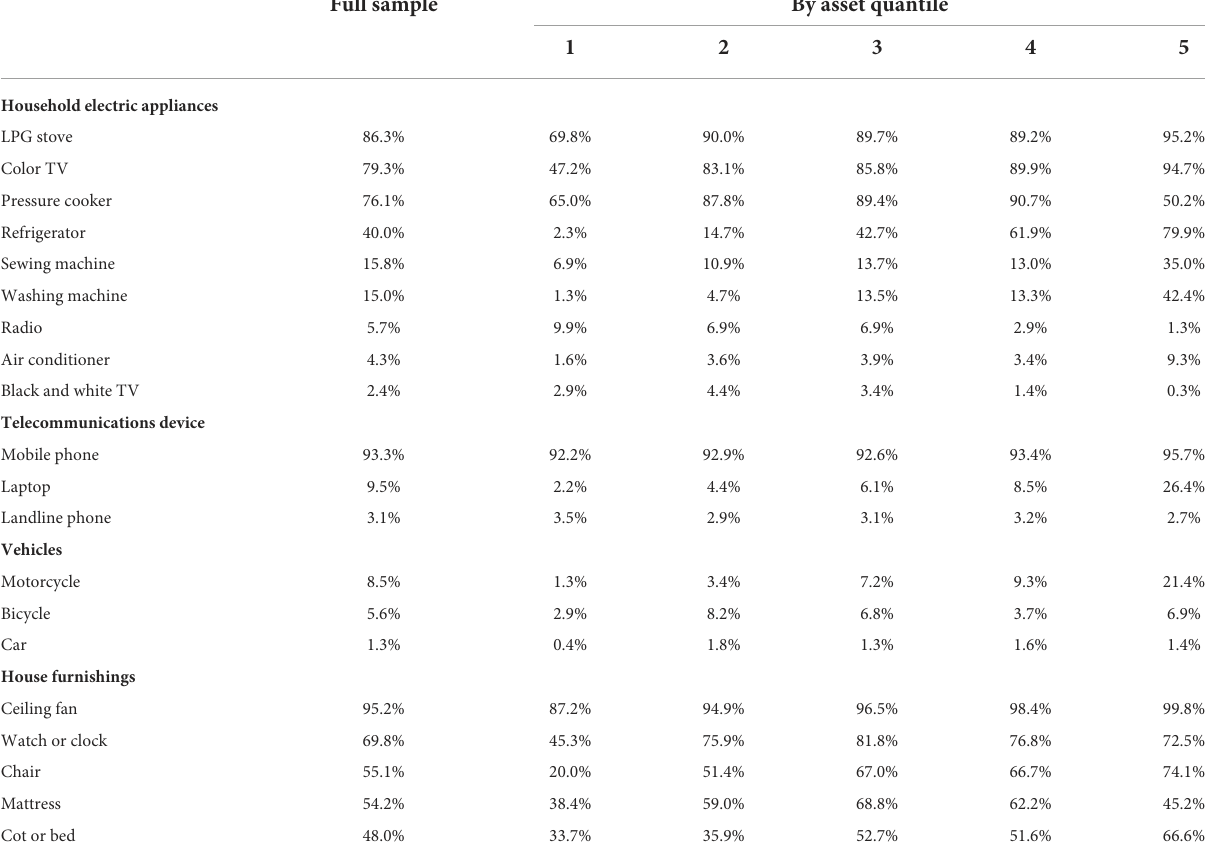
TABLE 5 Descriptive statistics (household asset